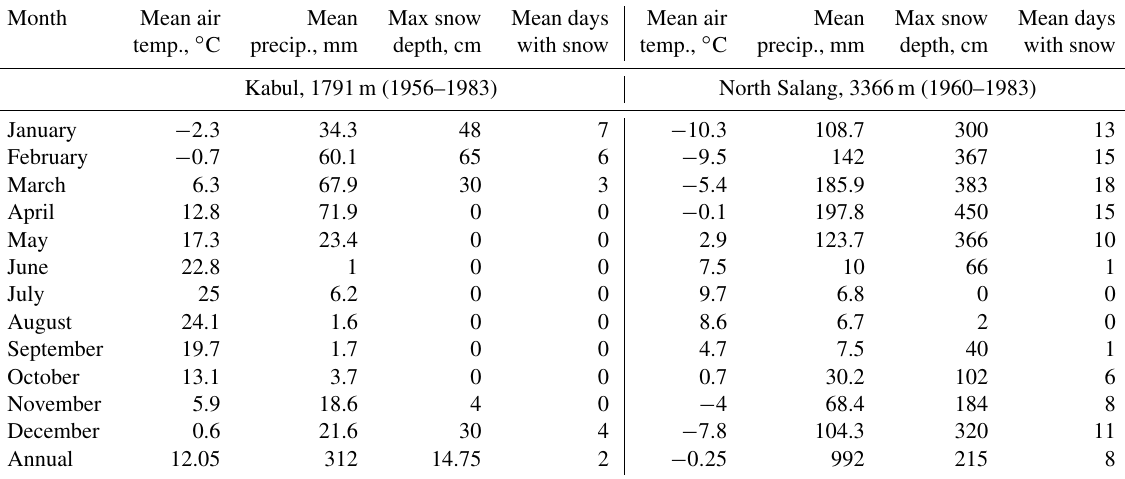
Table 1. Climate records (monthly averages) from Kabul and Salang